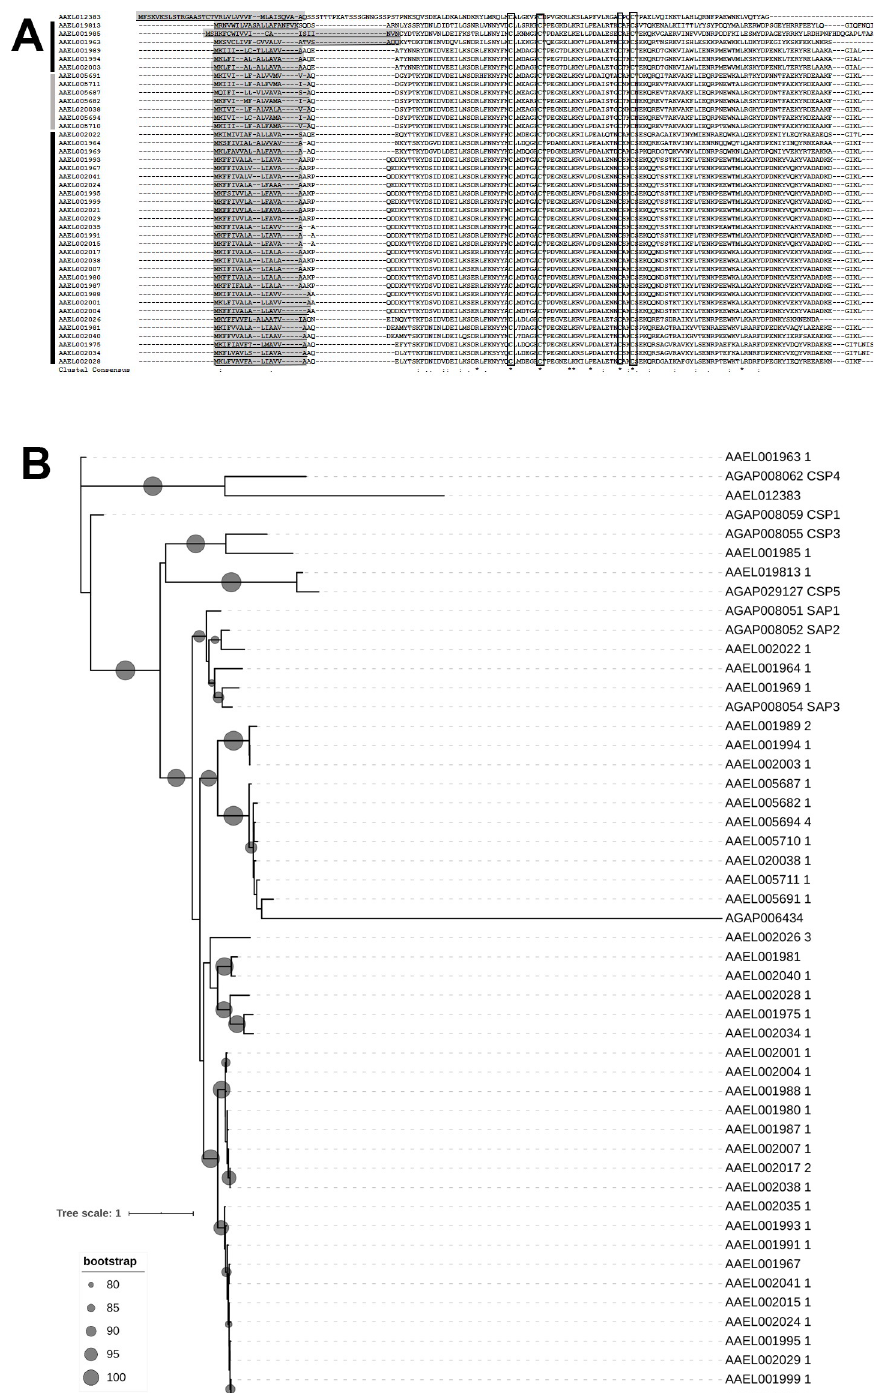
Fig 4. A. Multiple sequence alignment of chemosensory proteins identified in Ae . aegypti genome. Predicted signal peptide sequences are indicated underlined and with a light-gray shadow. Conserved cysteine residues are boxed. For clarity reasons, only the conserved region of the larger sequences (AAEL001985 and AAEL019813) are shown. In the last line of each alignment, an asterisk indicates a fully conserved residue, a colon indicates a conservative substitution with strongly similar properties, and a period indicates a semiconserved substitution with weakly similar properties. Black bar in the left indicates sequences located in chromosome 2 cluster; gray bar indicates sequences located in chromosome 3 cluster. B. Phylogenetic analysis of Ae . aegypti and An . gambiae chemosensory proteins constructed